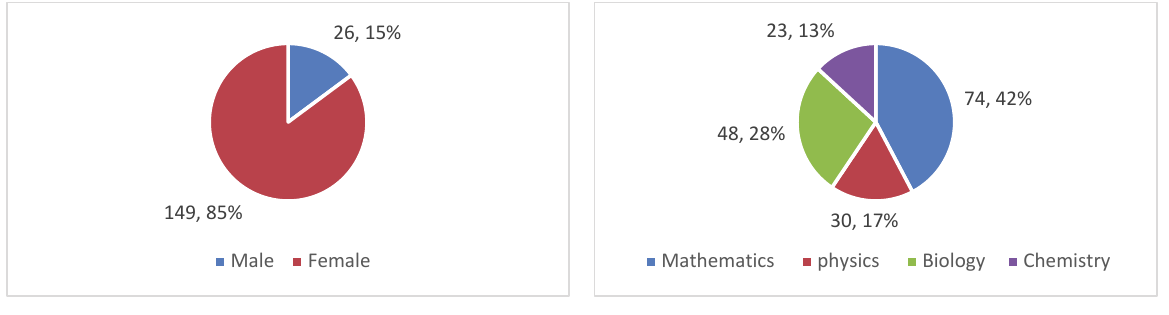
Fig. 1. characteristics of independent variables